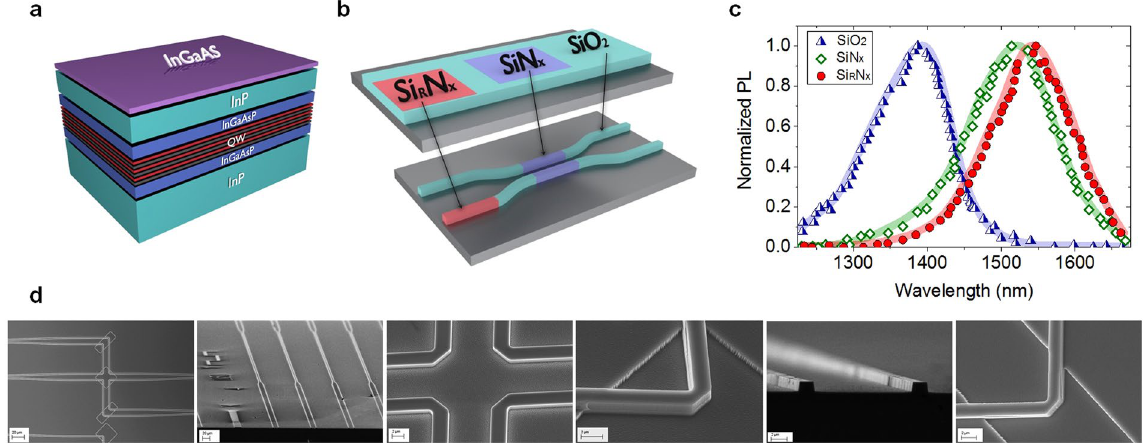
Figure 2. Fabrication process. ( a ) Cross-sectional view of the quantum well wafer used. ( b ) Schematic illustration of the intermixing process. SiO 2 , SiN x and Si-rich Si R N x capping layers are employed to spatially fine- tune the optical bandgap in the different sections required for this unidirectional system. ( c ) Photoluminescence response of the resulting three intermixed regions corresponding to ND (green), passive waveguide (blue) and SOA (red) segments. ( d ) Scanning electron microscope pictures at various stages of the fabrication process. The different components needed for the 4-port re-router (SOAs, NDs, mirrors, etc) are depicted.